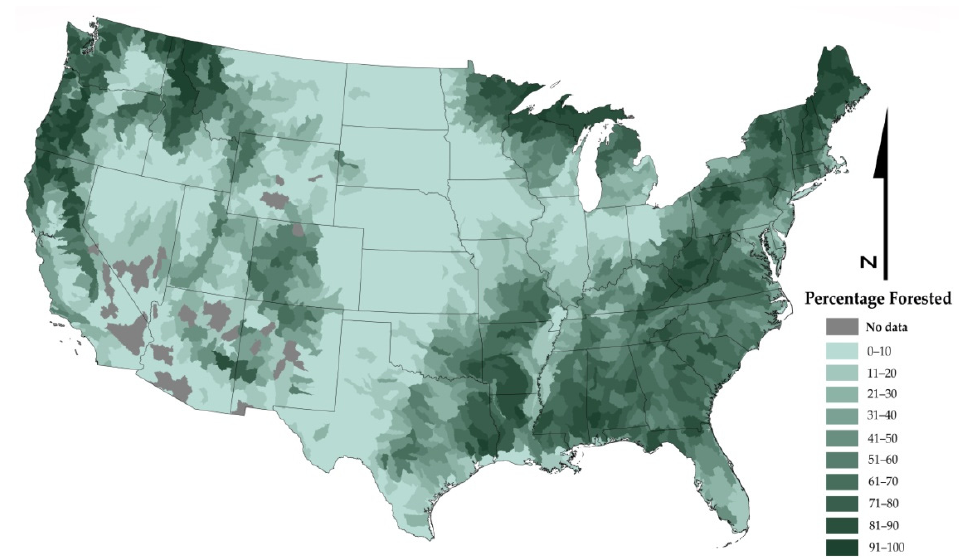
Figure 3. Percentage forested of each HUC8 unit in the conterminous United States.